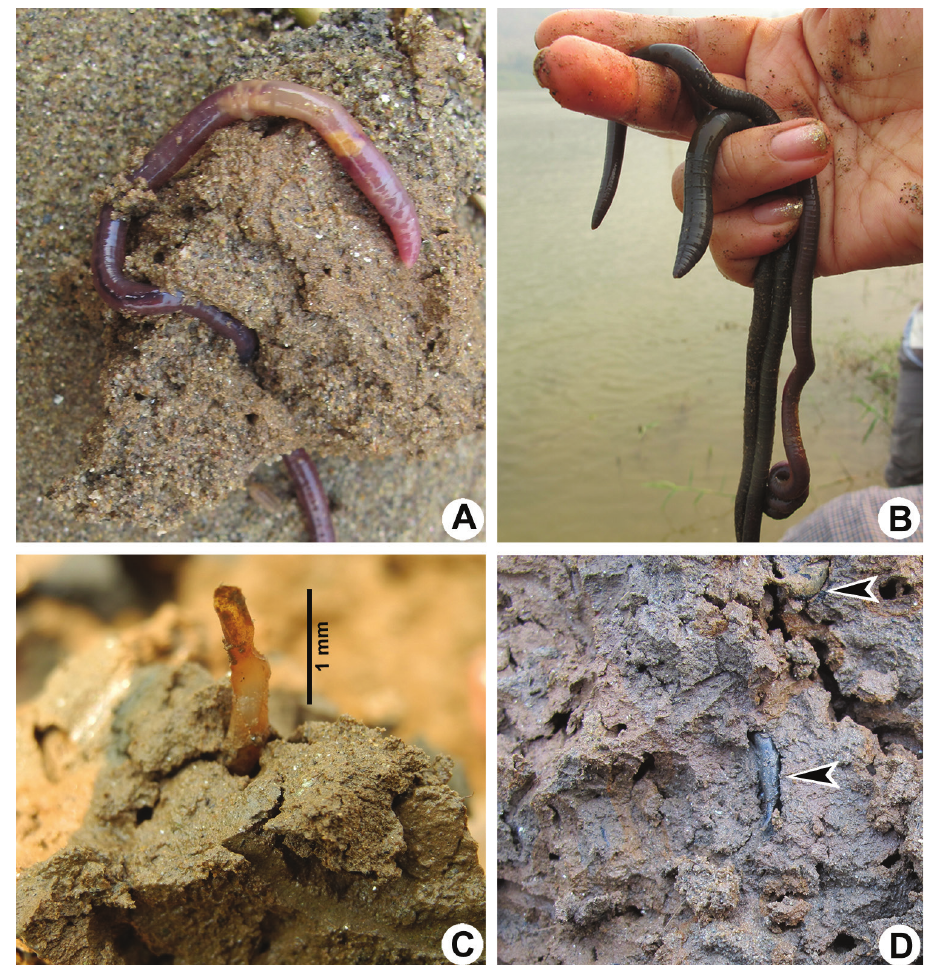
Figure 13. Photographs showing A Metaphire sp. B Amynthas mekongianus (Cognetti, 1922) C and D Cocoons of Glyphidrilus in the